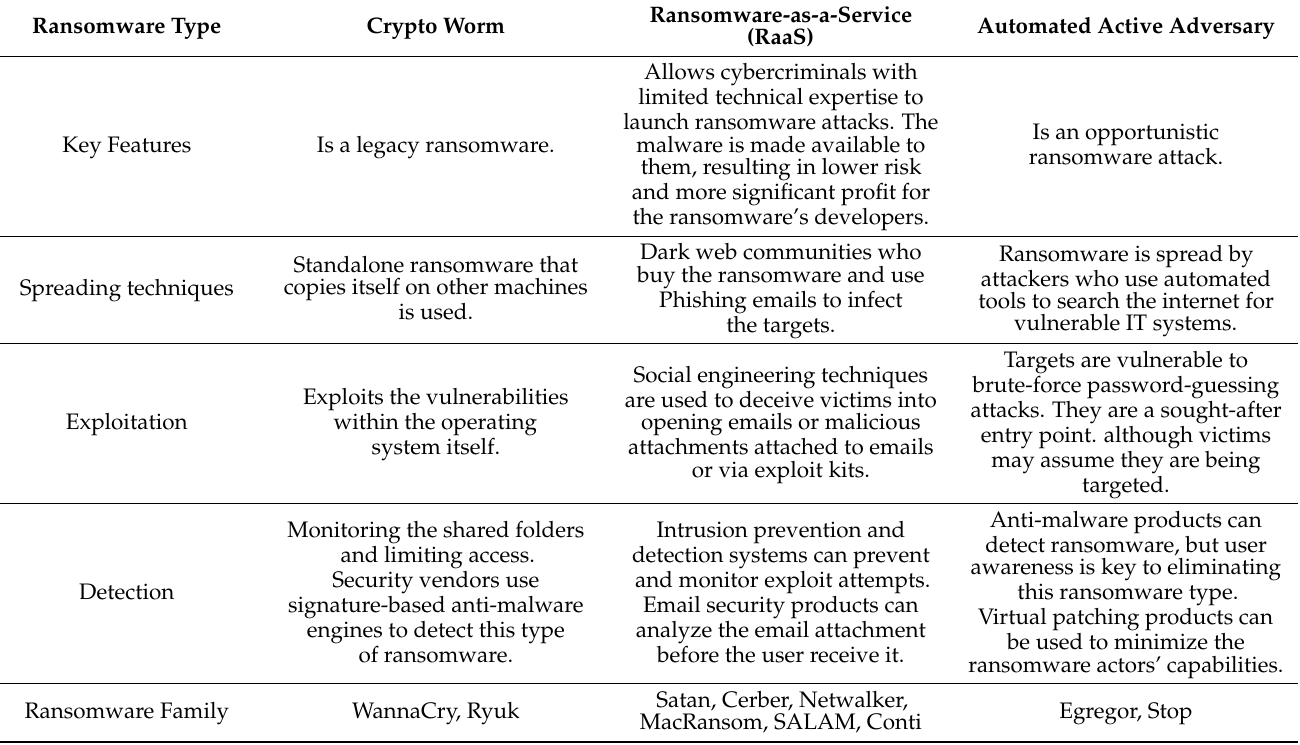
Table 2. Comparison Between Ransomware Malware Behavior Types.